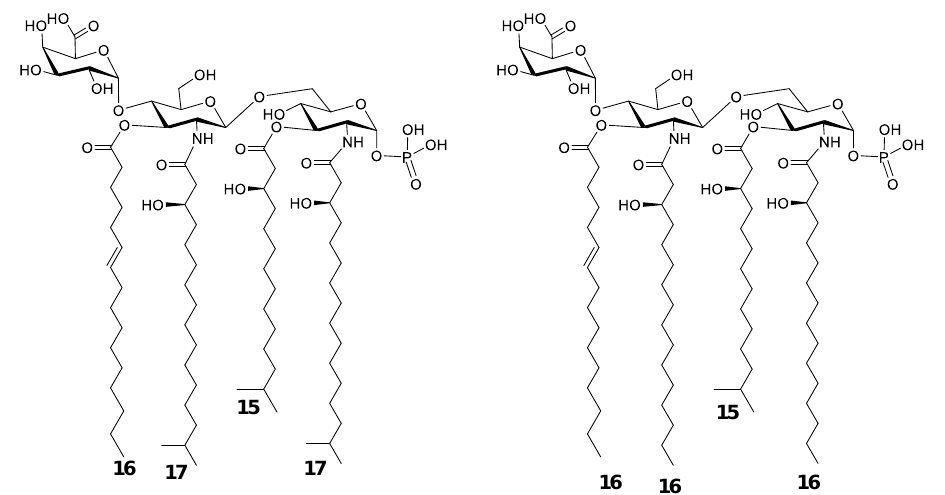
Figure 9. The proposed structure of the main lipid A species identified for E. pacifica KMM 6172 T ( a ) and E. vietnamensis KMM 6221 T ( b ) LPS via MALDI-TOF MS and MS/MS investigation in combination with compositional